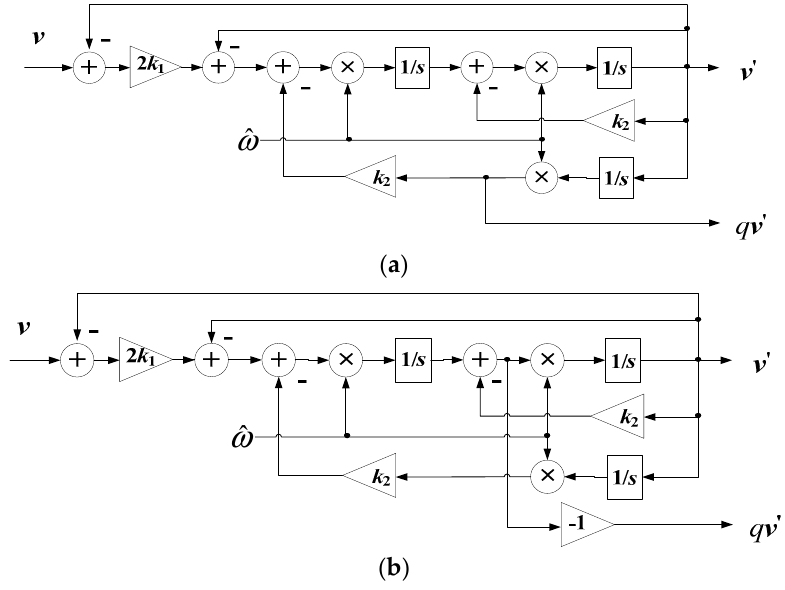
Figure 2. The implementation of TOGI and MTOGI. ( a ) TOGI; ( b ) MTOGI.